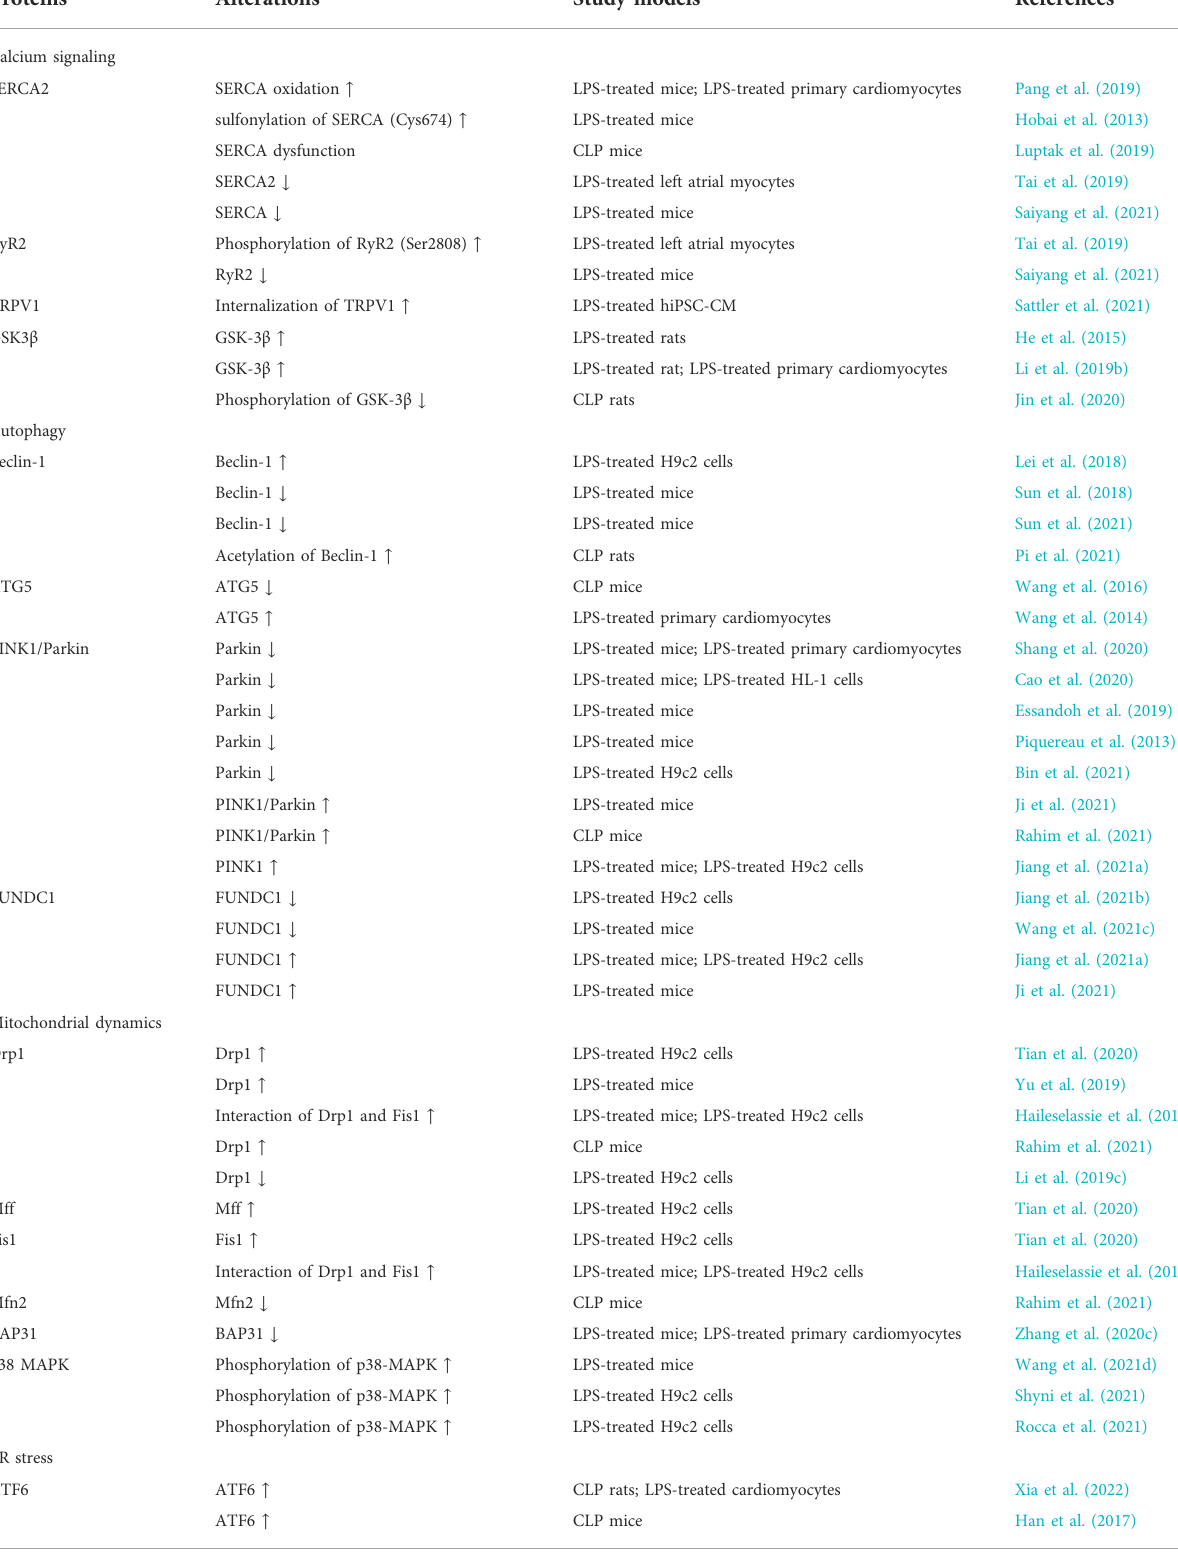
TABLE 1 Components of MERCs involved in